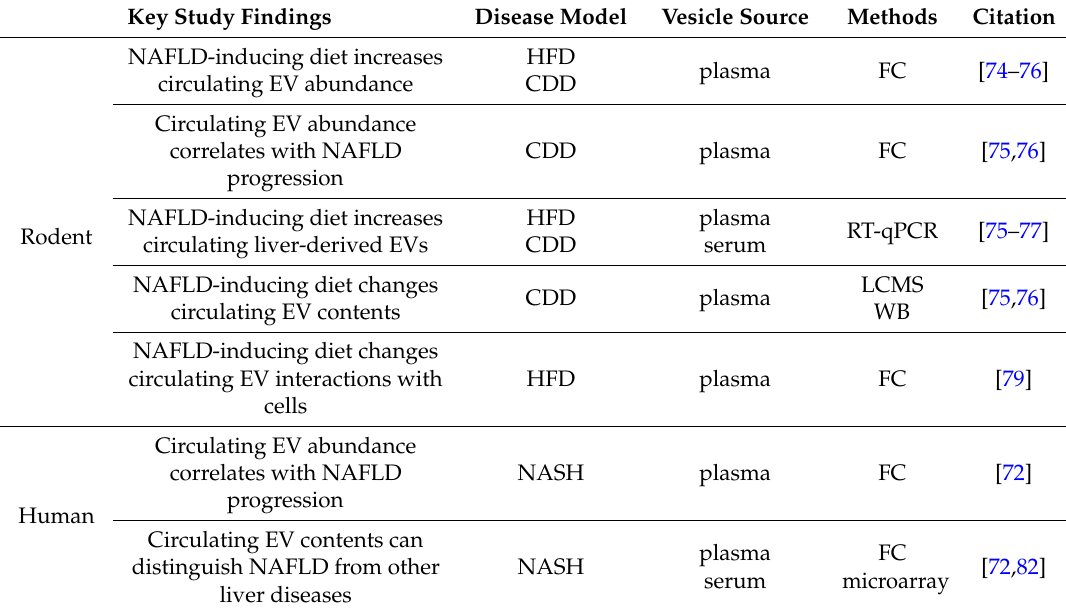
Table 2. Important findings for extracellular vesicles in the context of NAFLD. Key Study